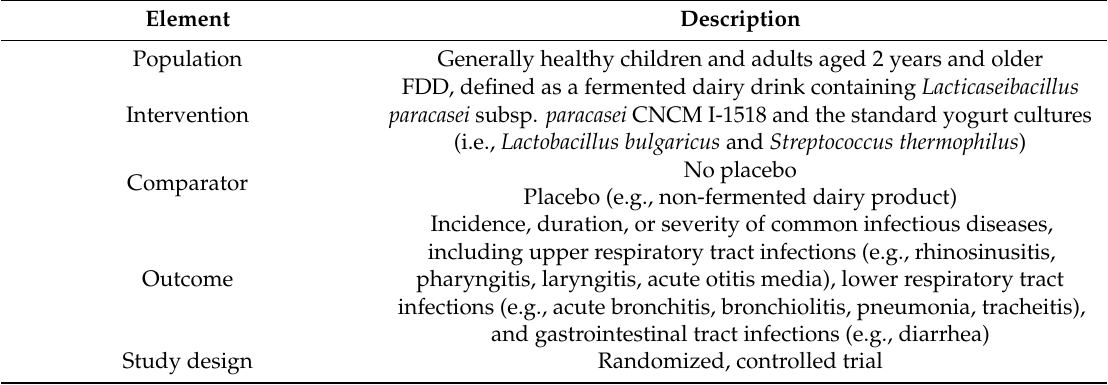
Table 1. Population, Intervention, Comparator, Outcomes, Study design (PICOS) framework.